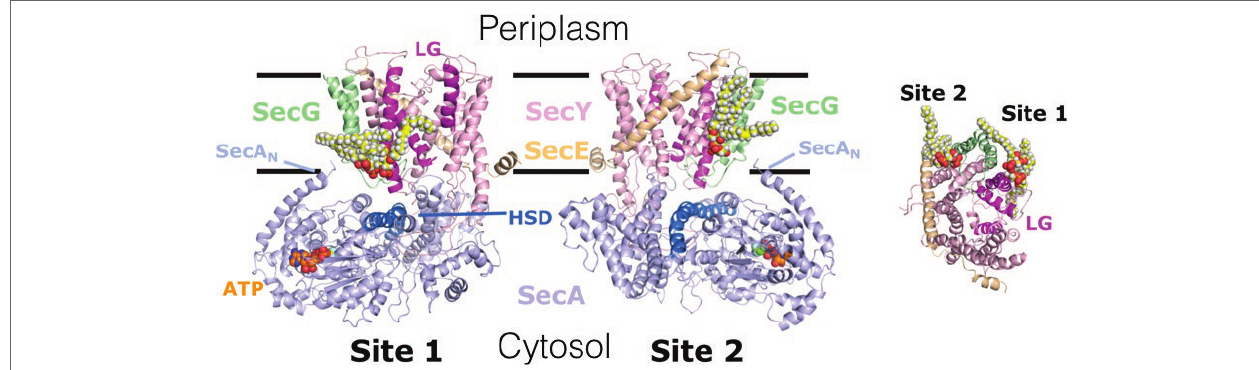
FIGURE 3 | Interaction of cardiolipin (CL) with the bacterial translocon. 2 CL (yellow, white, and red spheres) – binding sites 1 & 2 – on SecYEG; identified by CGMD, validated and shown to be critical for ATP and PMF-driven secretion (Corey et al., 2018). Left and middle, side view of SecYEG bound to the motor ATPase SecA; right, cytosolic view of SecYEG alone. In SecA: ATP, SecA N – N-terminus; HSD (including the 2HF) – helical scaffold domain, at the entrance to the protein channel in SecY. In SecYEG: LG – lateral gate, which opens during transport of proteins across and into the membrane. Adapted from Corey et al. (2018), used with